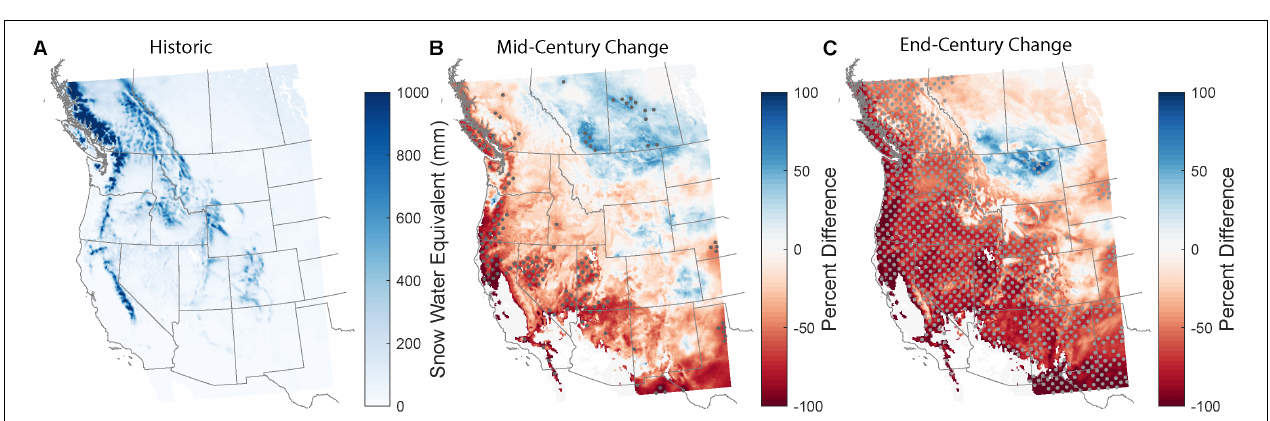
FIGURE 8 | Average hydrographs for basins with headwaters in the Sierra Nevada mountains for the historic (blue), mid-century (orange), and end-century (yellow) decades.